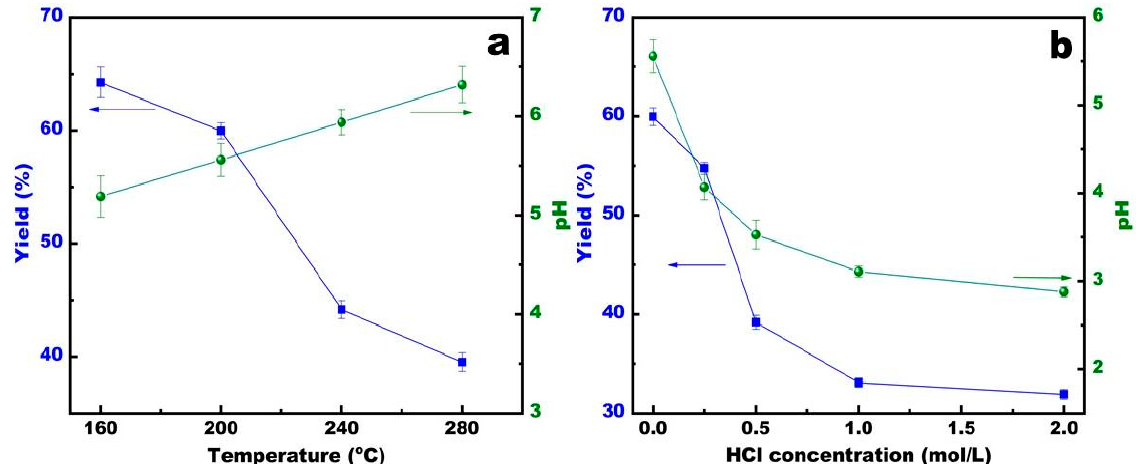
Figure 1. The yield and pH of hydrochar formed in different temperatures ( a ) and treated with different HCl concentrations ( b ). Table 1. Concentration (mg · kg − 1 ) of heavy metals in hydrochar formed by HTC at different HCl